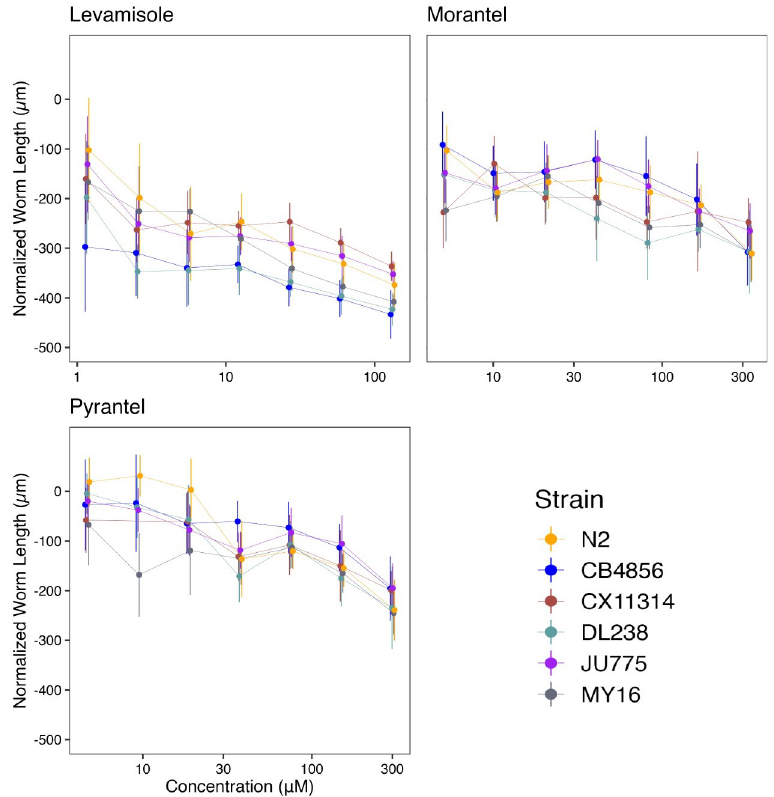
Fig 6. Dose-response curves for nicotinic acetylcholine receptor (nAChR) agonists. Normalized animal lengths (y- axis) are plotted for each strain as a function of the dose of anthelmintic supplied in the high-throughput phenotyping assay (x-axis); Levamisole, Morantel, and Pyrantel. Strains are denoted by color. Lines extending vertically from points represent the standard deviation from the mean response. Statistical normalization of animal lengths is described in Methods